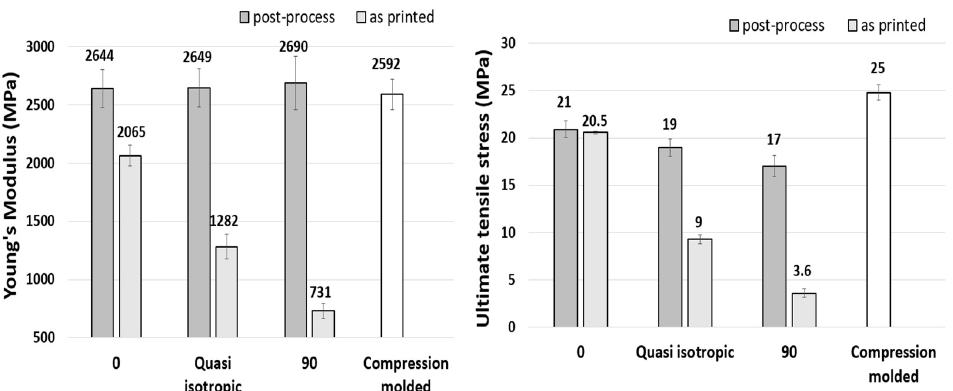
Figure 4. Young’s modulus and ultimate tensile stress of each laminate, both post-processed and as-printed, and compression-molded samples. The error bars represent the standard deviation.